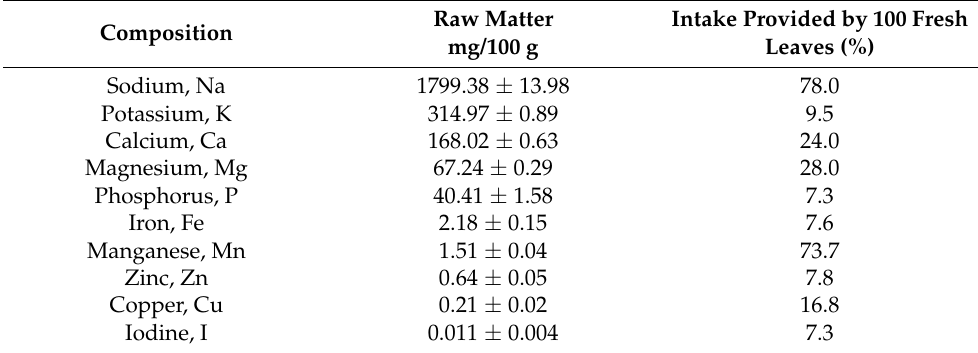
Table 2. Mineral composition (mg/100 g raw matter) and the mineral intake (%) provided by 100 g of fresh leaves of H. portulacoides